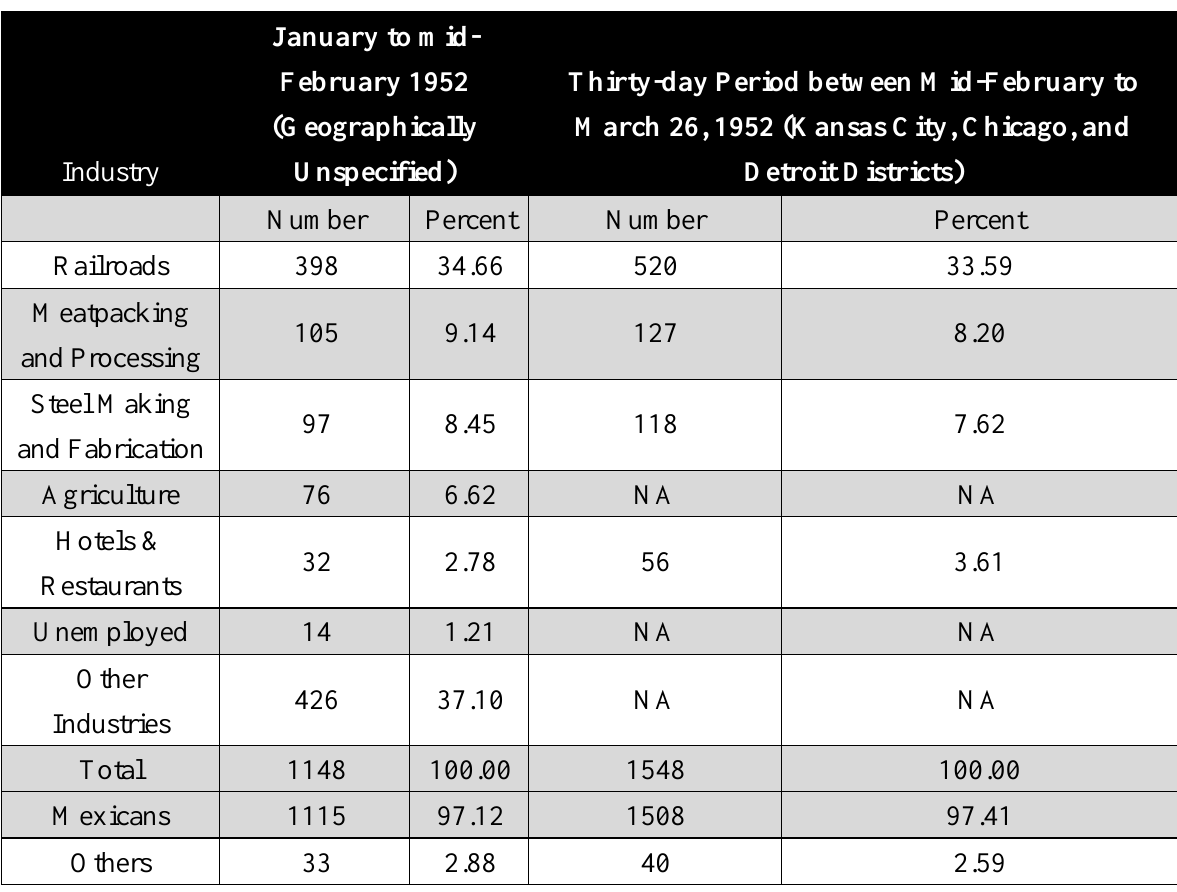
Table 3. INS Deportations by Industry, early